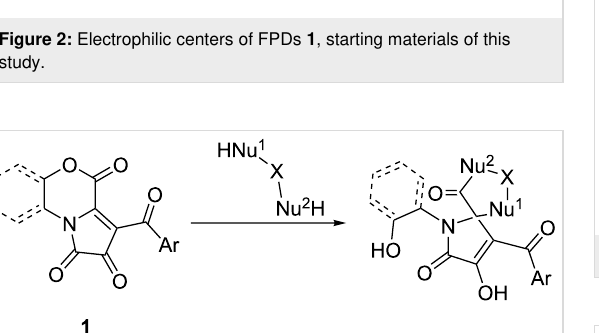
Scheme 3: Cyclocondensation of FPDs 1 with 1,3-binucleophilic reagents, resulting in pyrrole-2-one-bearing spiro[4.4]